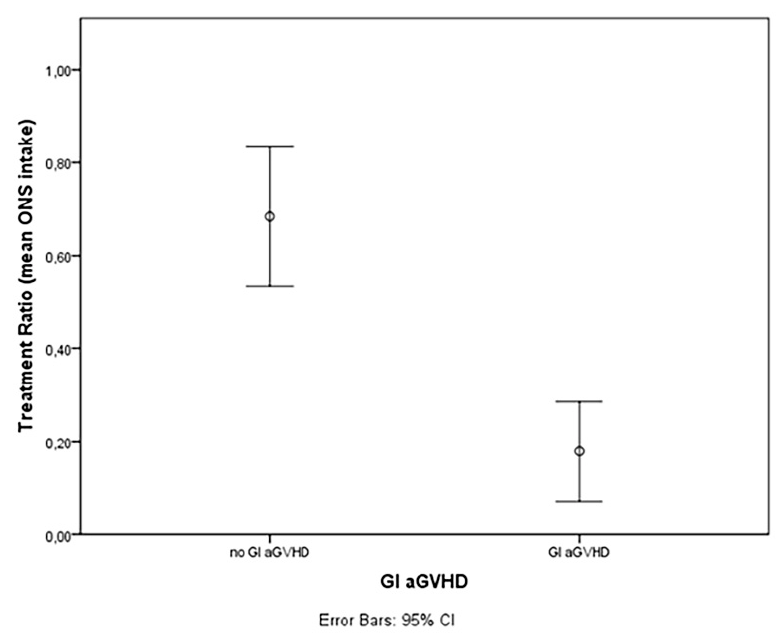
Figure 5. Mean TE-OPF assumption in patients with gastrointestinal GVHD compared with patients without GVHD (17.8% vs. 68.3%, p = 0.002, Mann–Whitney test).